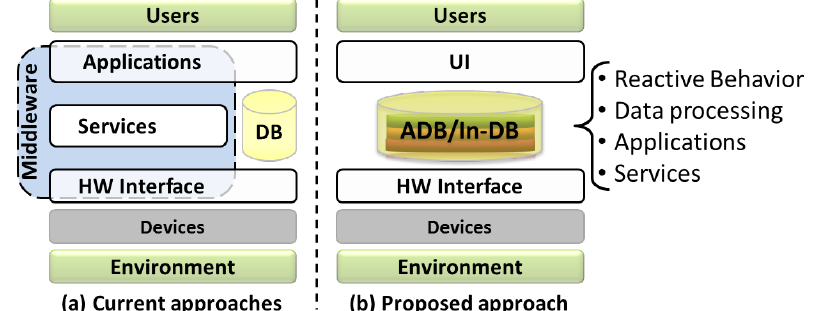
Figure 1. ( a ) Existing infrastructures supporting smart environments and AAL systems perform data processing at different layers; ( b ) in the proposed database-centric